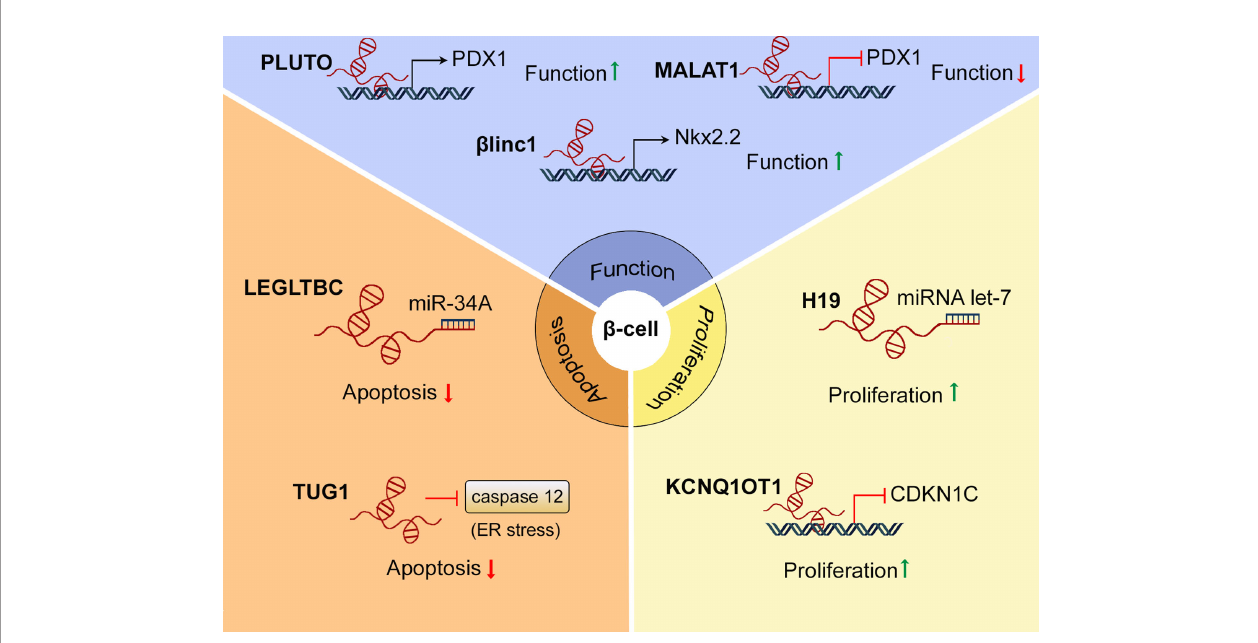
FIGURE 3 | Roles of lncRNAs in b -cell mass and function. Several lncRNAs, including PLUTO, MALAT1, and b linc1 have been found to regulate b -cell function by modulating the expression of b -cell signature genes. LncRNAs as LEGLTBC and TUG1 protect b -cells from apoptosis in response to different stimuli. H19 and KCNQ1OT1 are involved in b -cell mass expansion during development, promoting b -cell